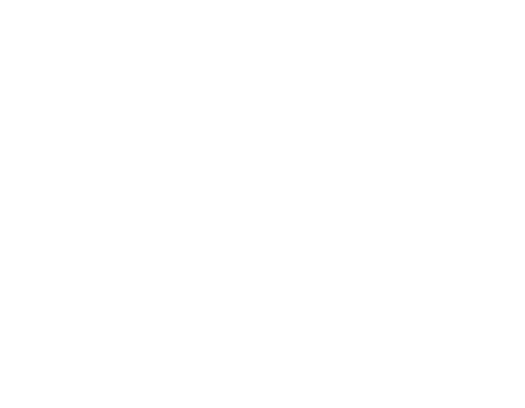
Figure 8. The histogram of OOT values obtained for eight coordinative compounds of copper with various ligands at three heating rates (°C min − 1 ): ( white ) 5; ( dark grey ) 10; ( black ) 15 [134].